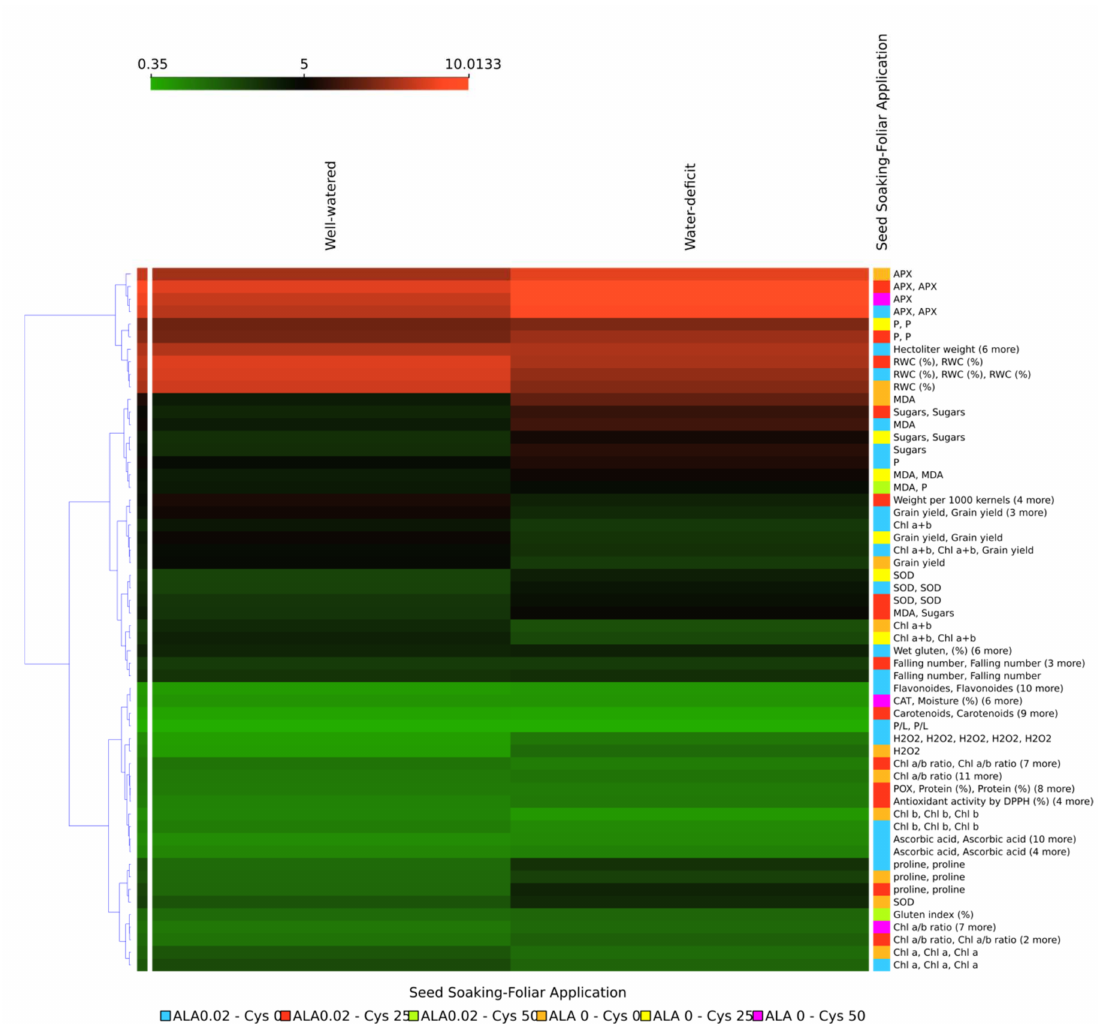
Figure 10. Two-dimensional heatmap visualization shows the interaction between the irrigation treatments and both the 31 measured parameters included in the study and the six “seed soaking and foliar application”